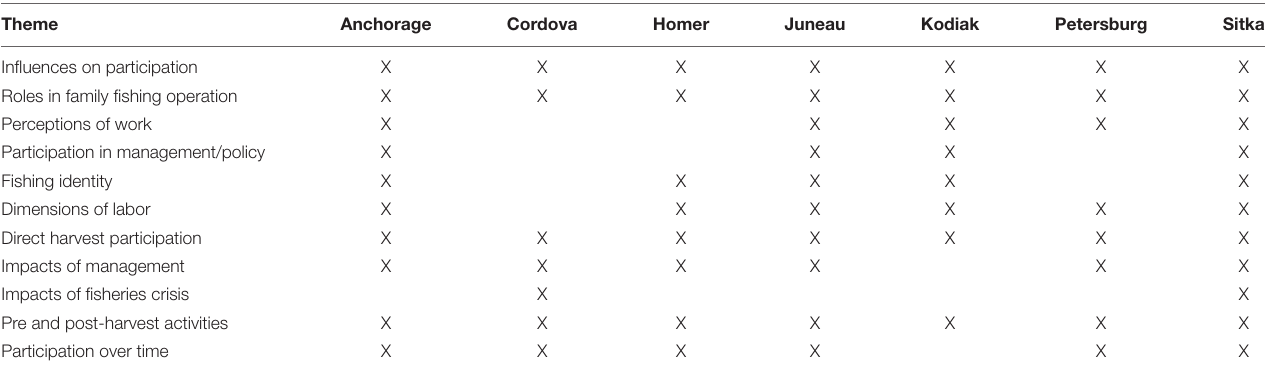
TABLE 5 | Distribution of themes across the seven focus groups in Gulf of Alaska communities.